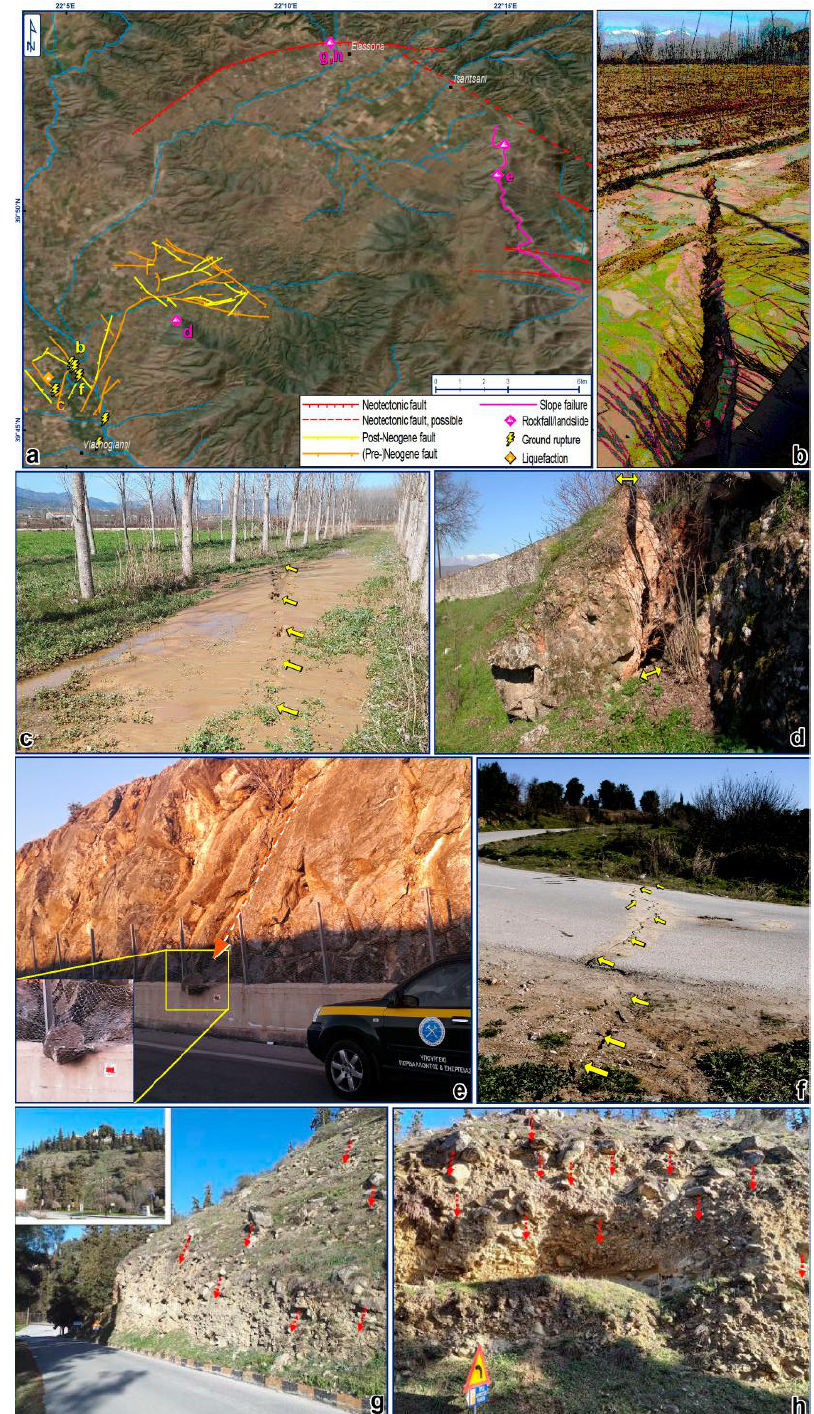
Figure 12. Ground deformation phenomena observed in the epicentral area of the 2021 earthquake sequence. ( a ) Satellite image with the locations of the ground deformation phenomena, the faults detected by Dimitriou and Giakoupis [50] (see also Figure 5b), and the neotectonic faults found in the literature (see also Figure 7d). ( b , c ) Ground ruptures (marked by yellow arrows) with liquefac- tion. ( d ) Gneiss-schist boulder detachment in Domeniko village. ( e ) Rockfalls along the Tyrnavos- Elassona highway. ( f ) Ground rupture (marked by yellow arrows) cutting through the asphalt road. ( g , h ) Rockfalls near the Panagia Olympiotissa Monastery (Elassona). Locations of all photographs are shown in ( a ). After Galanakis et al.